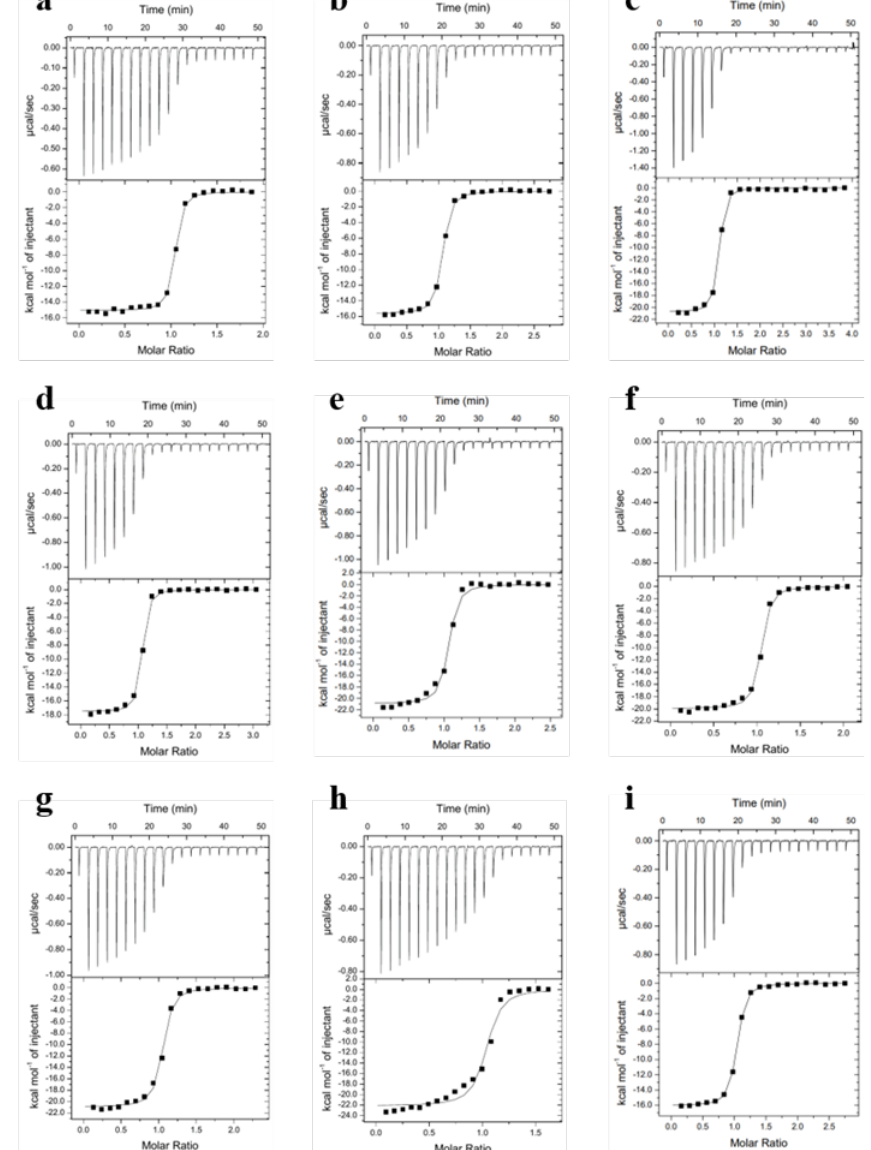
Figure 3. ITC curves showing ( a ) H3K4me3R8me2a; ( b ) H3K4me3Cit8me2; ( c ) H3K4me3hR8me2a;